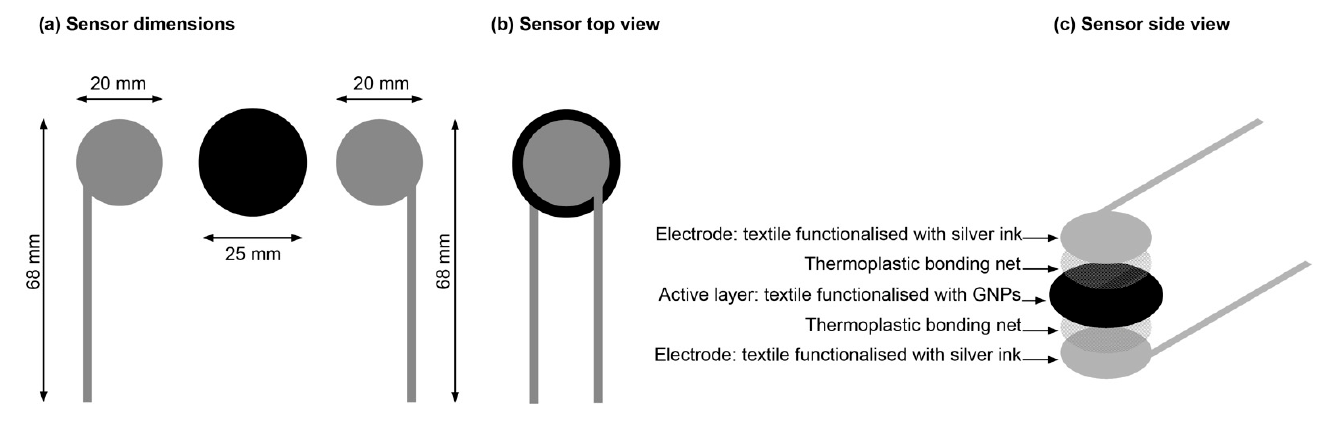
Figure 1. ( a ) Sensor dimensions; ( b ) Sensor top view; ( c ) Sensor side Figure 1 . ( a ) Sensor dimensions; ( b ) Sensor top view; ( c ) Sensor side view.